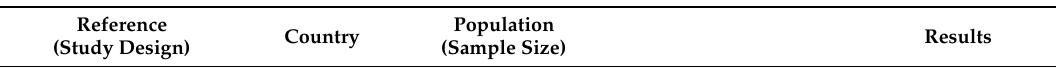
Table 9. Results on smoking.